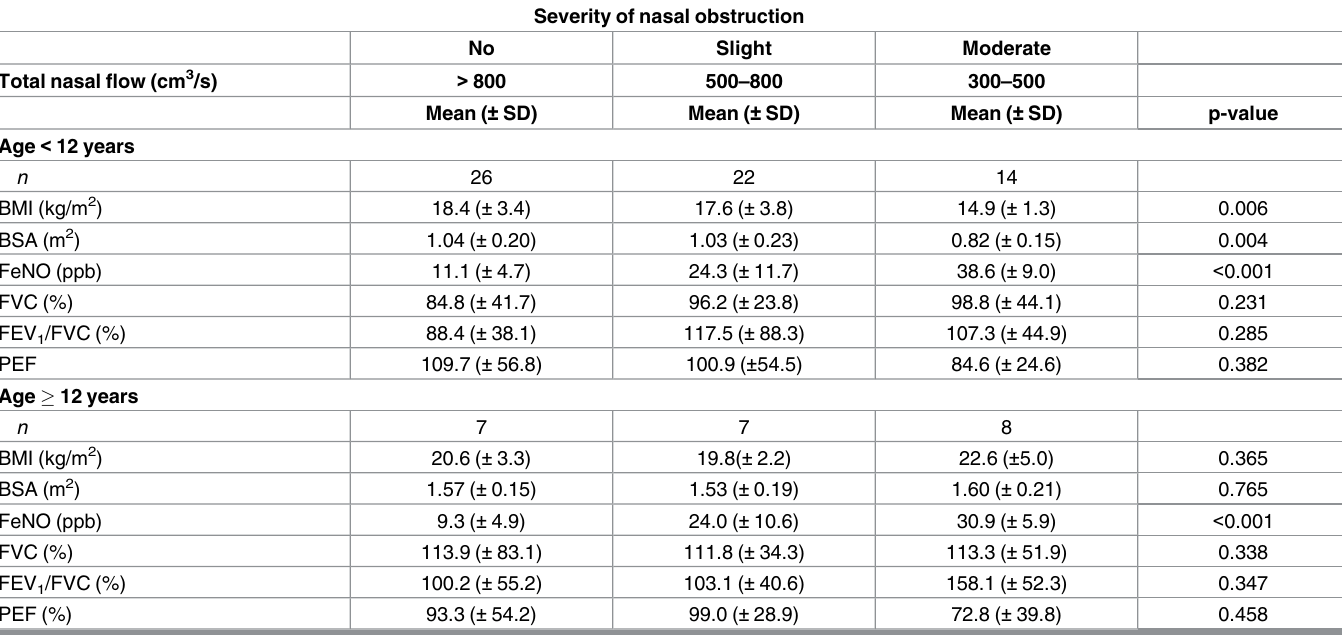
Table 3. Spirometric and rhinomanometric measurements in patients differentiated by symptoms of nasal obstruction.